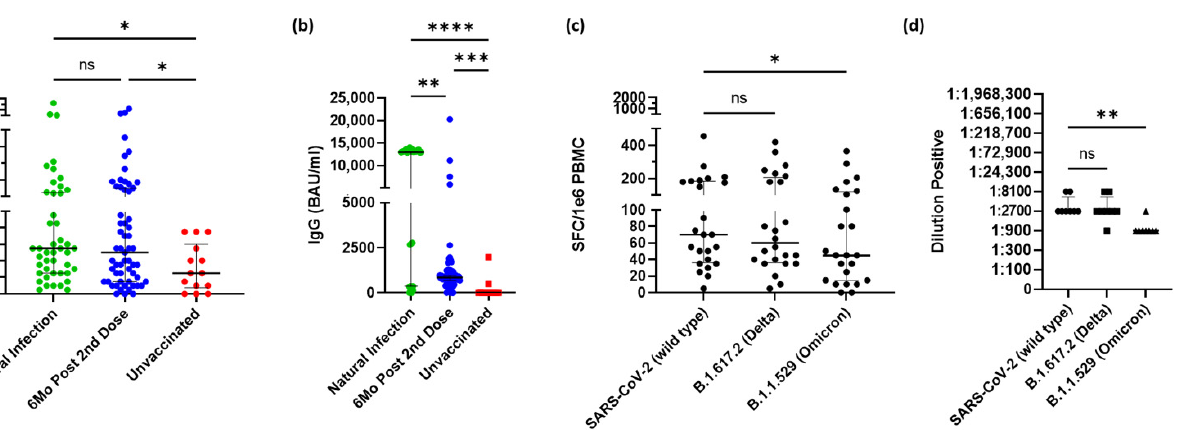
Figure 1. Oncology workers have a comparable immune response to naturally infected individuals within 6 months following a full vaccination regimen but still greater than unvaccinated oncology workers. ( a ) Spike-specific CD4 + T-cell response in participants during natural infection (acquired from separate study, n = 45), within 6 months of their last dose of a vaccine ( n = 60) or have never received a vaccine ( n = 14). ( b ) Spike-specific IgG antibody response from same participants. ( c ) Spike-specific CD4 + T-cell response to the wild type, Delta, and Omicron variants within 6 months after second dose of initial vaccination ( n = 24). ( d ) Spike-specific antibody response to the wild type, Delta, and Omicron variants within 6 months after second dose of initial vaccination. Middle black bar represents median with outer bars representing interquartile range. Kruskal – Wallis test ( a , b ) or Friedman test ( c , d ) were used for group comparisons. Abbreviations: SFC, spot forming cells; IgG, immunoglobulin G; BAU, binding antibody units; NS, no significance. * p < 0.05, ** p < 0.01, *** p < 0.001, **** p < 0.0001.